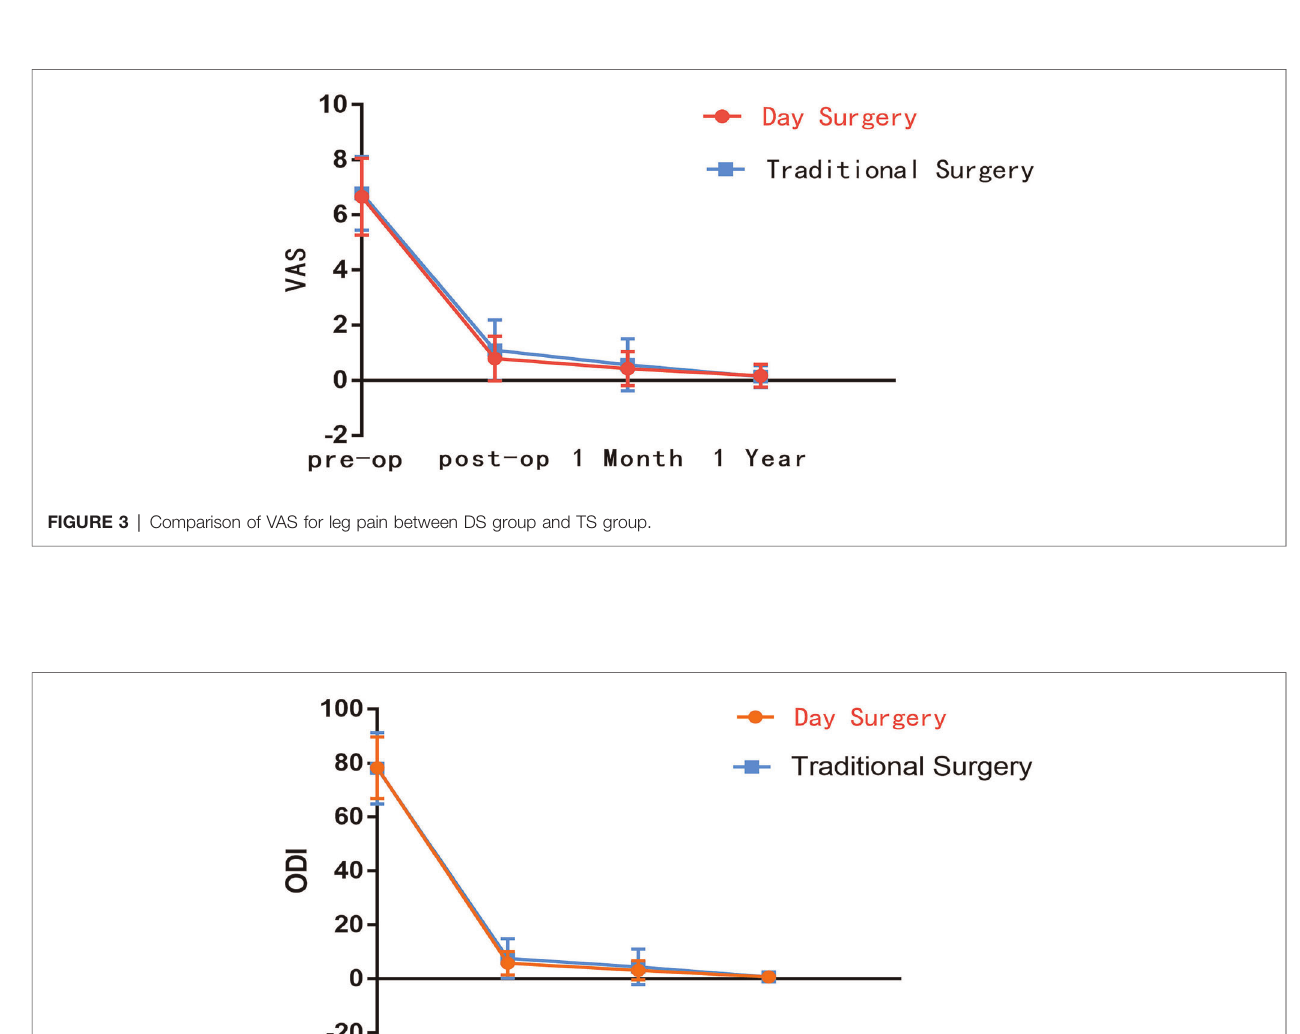
FIGURE 4 | Comparison of ODI between DS group and TS group.